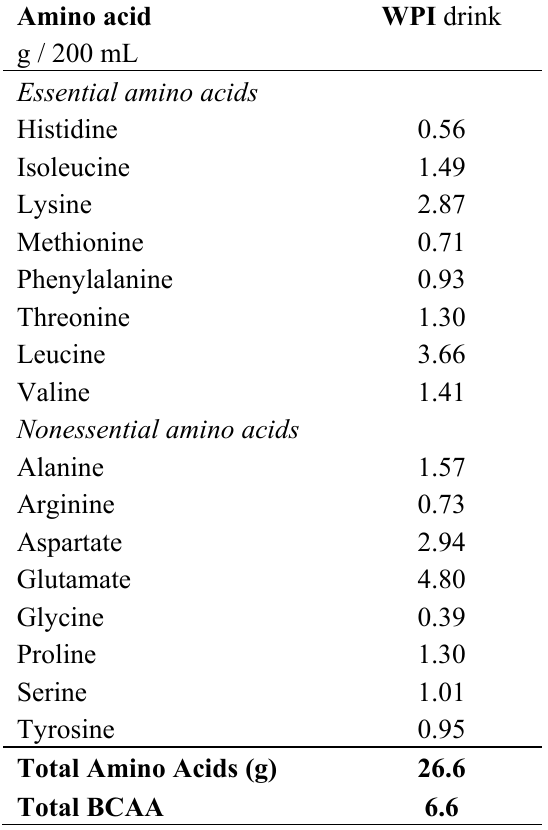
Table 2 Amino acid composition of WPI